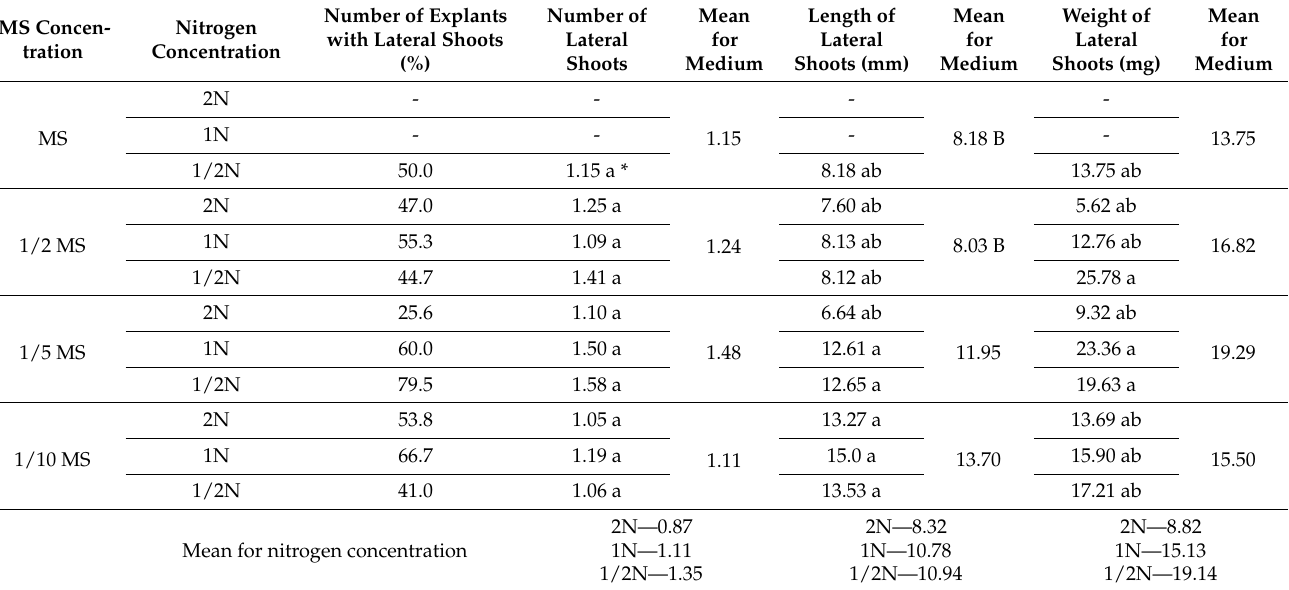
Table 5. Growth and development of Aldrovanda vesiculosa lateral shoots depending on the concentra- tion of the media and nitrogen